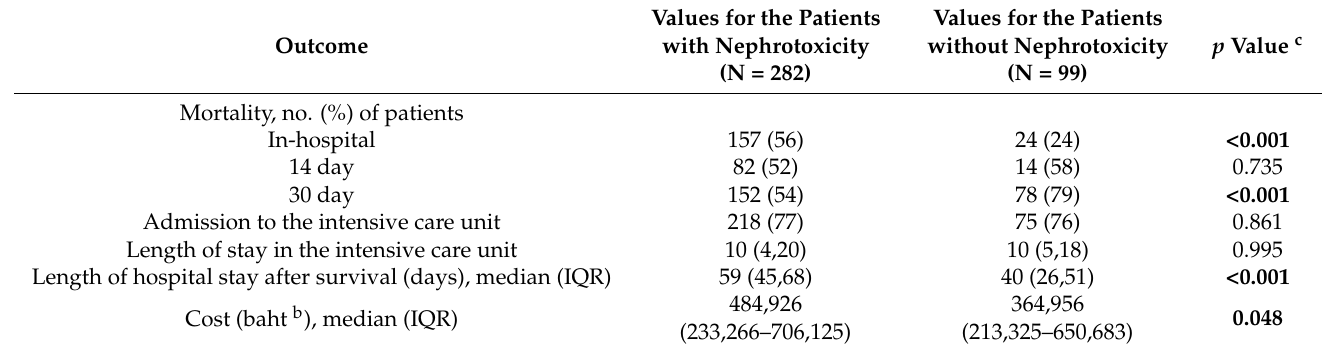
Table 3. Comparisons of outcomes for the patients receiving intravenous colistin with and without nephrotoxicity a . Outcome